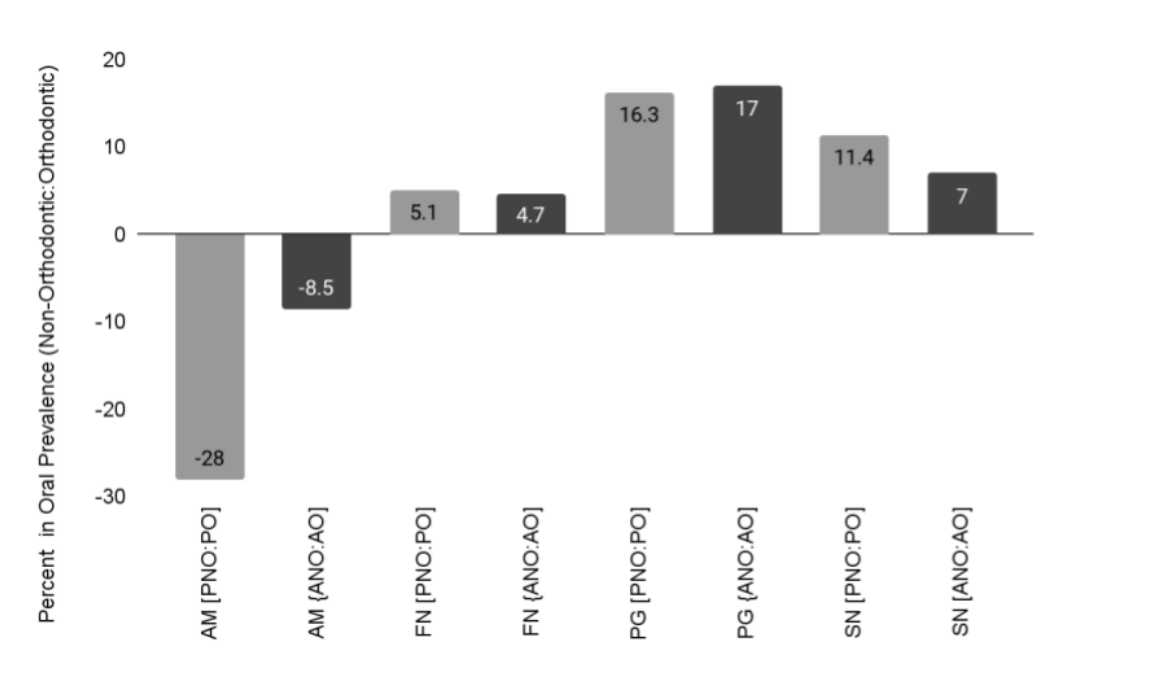
Figure 4. Orthodontic-associated differences in oral microbial prevalence. Decreased oral prevalence between non-orthodontic and orthodontic samples was observed for Akkermansia muciniphila (AM) with the largest differences observed between the pediatric samples. In addition, other orthodontic-related changes were observed with Fusobacterium nucleatum (FN), Porphyromonas gingivalis (PG) and Selenomonas noxia (SN), although those differences were more similar in direction (positive or negative) and magnitude between adult and pediatric samples.